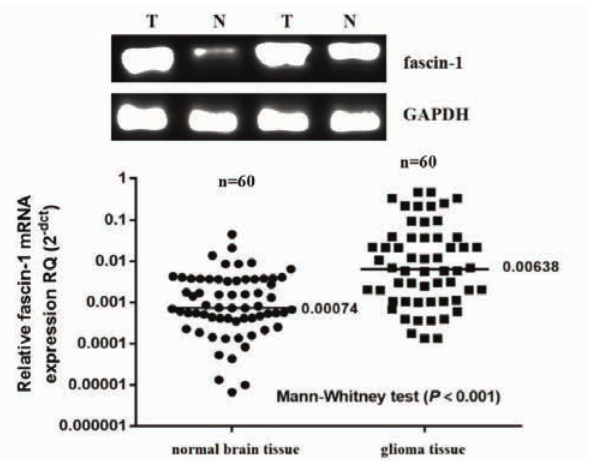
Figure 2: The fascin-1 mRNA was detected by RT-PCR. T: glioma tissue; N: normal brain tissue. Table 1: Clinicopathological features and fascin-1 protein expression in glioma